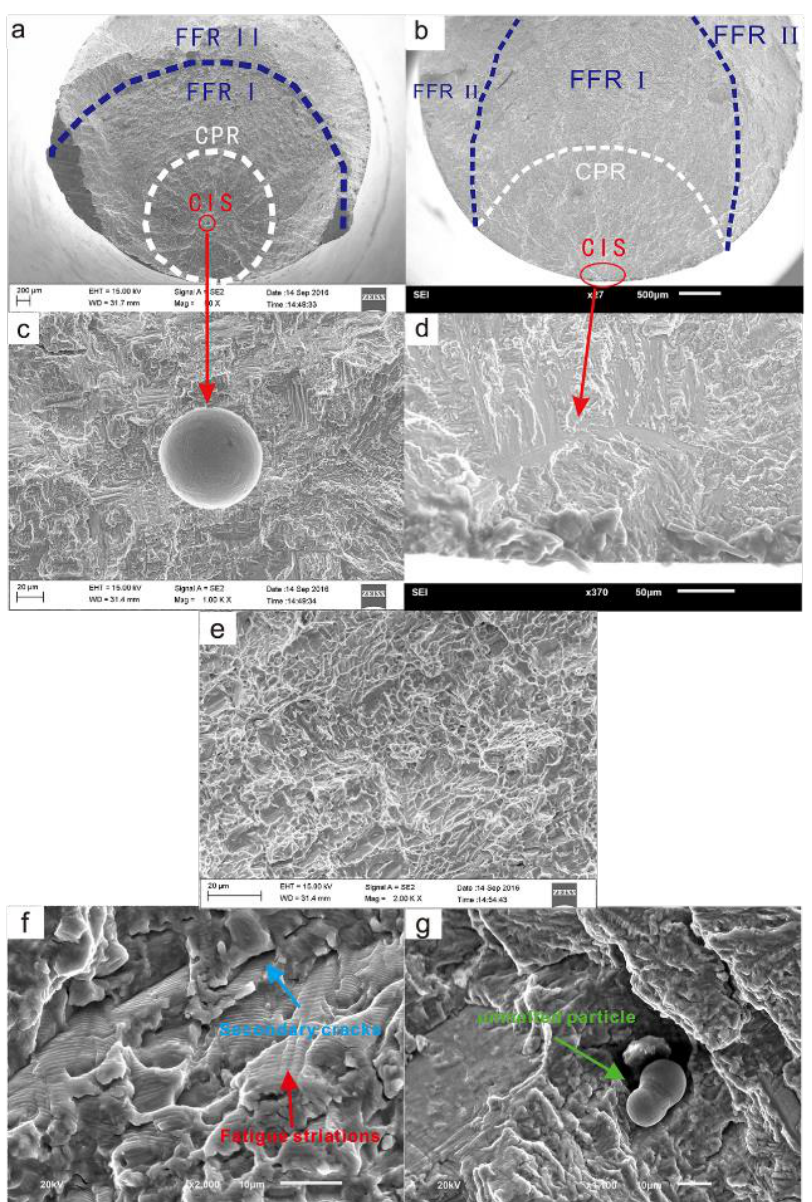
Figure 4. Typical fracture photographs of ( a ) SII and ( b ) SIS and fracture surface region details of ( c ) SII and ( d ) SIS; ( e ) typical dimple feature in the fast fracture region (FFR); ( f ) typical fatigue striations and ( g ) secondary cracks and unmelted particles in the crack propagation region (CPR).